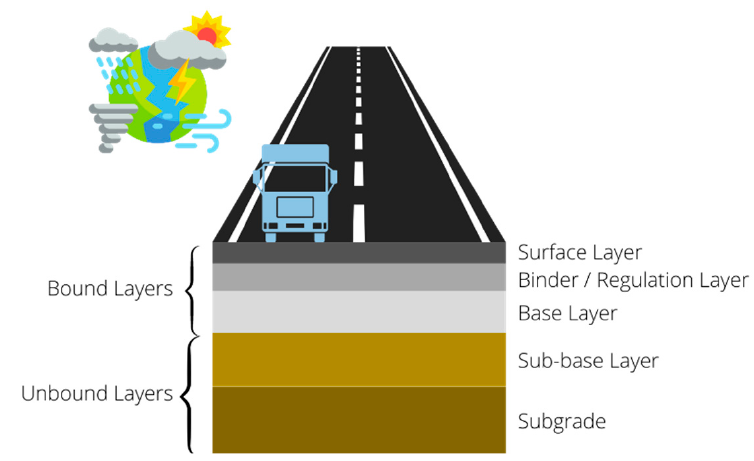
Figure 1. Pavement structure.